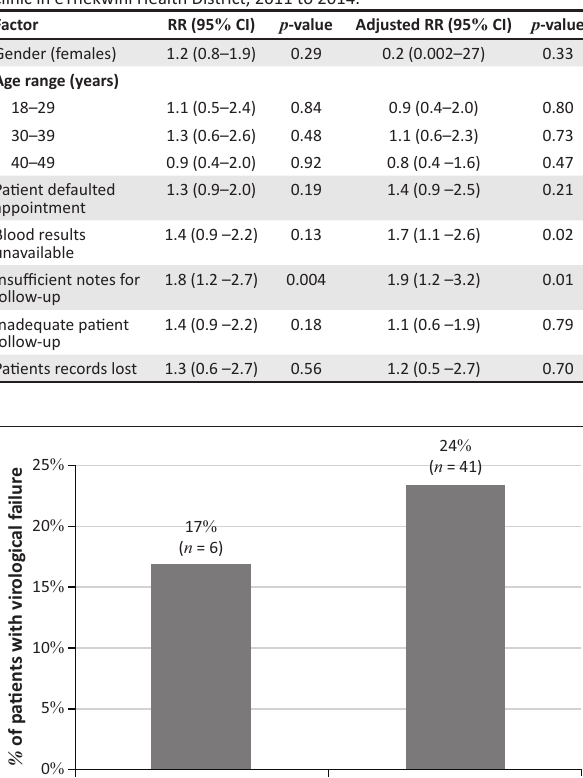
TABLE 2: Patient-related and programmatic variables associated with delays in switching patients to second-line antiretroviral treatment at an antiretroviral clinic in eThekwini Health District, 2011 to